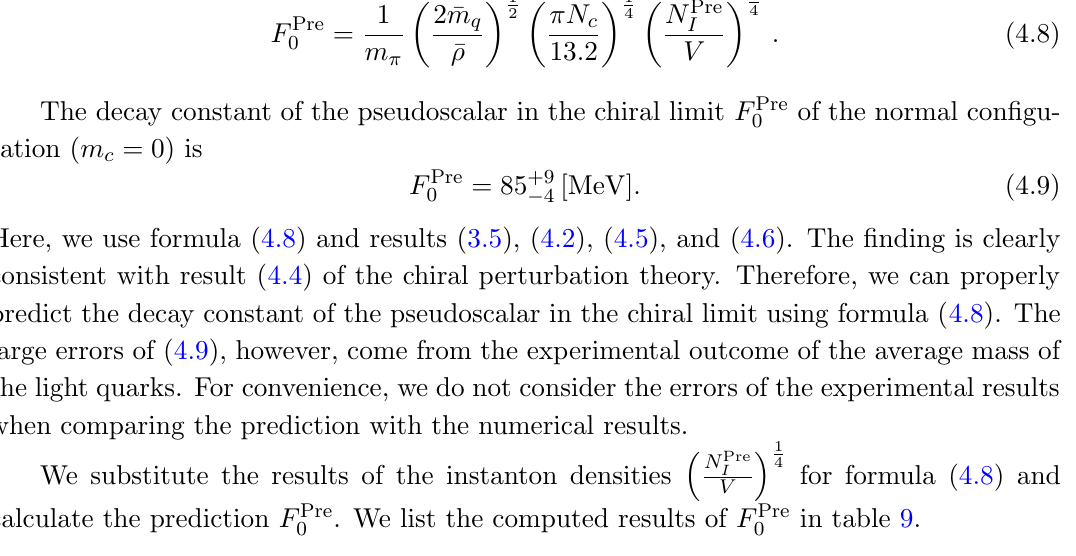
(cid:16) (cid:17) 1 (cid:16) (cid:17) 1 N Pre I N Pre I 2 and 4 . V V 0